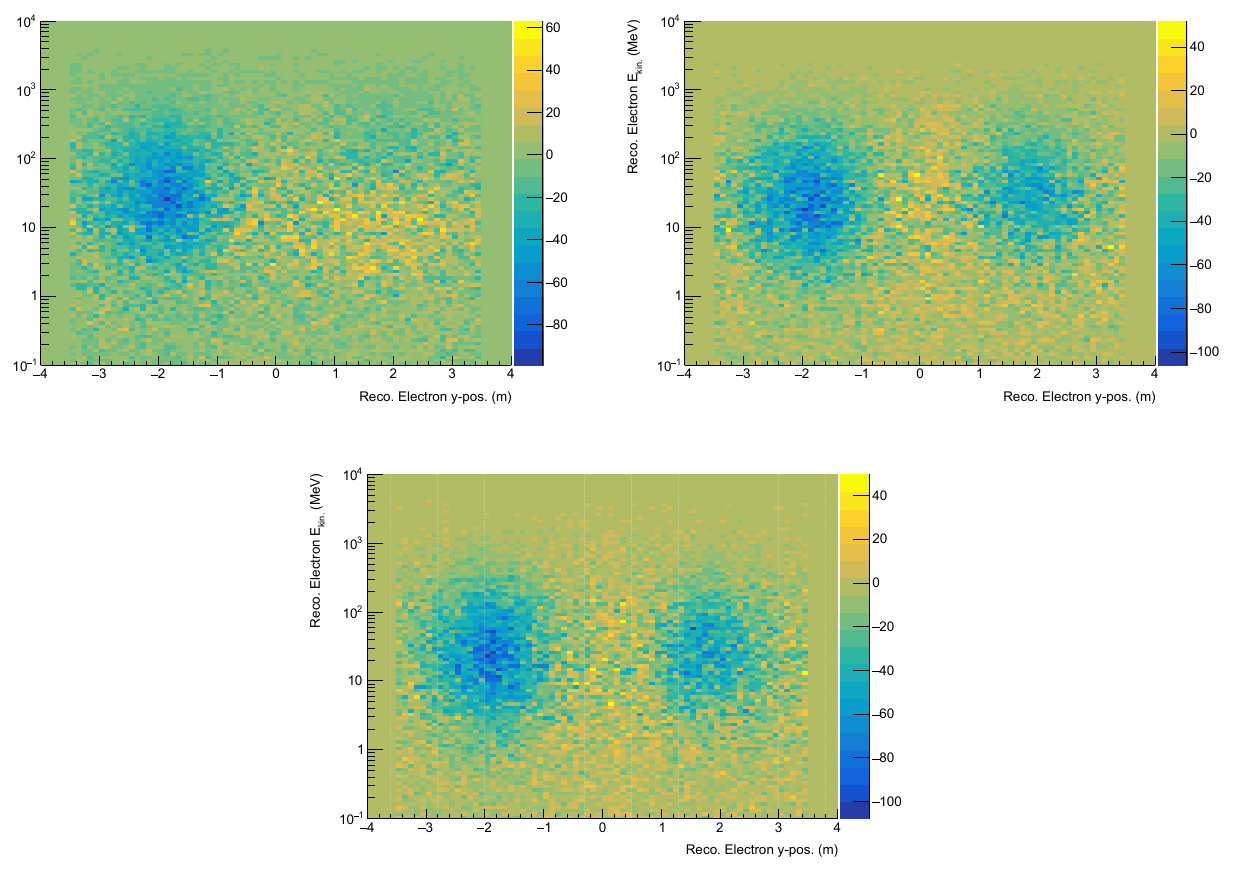
Figure 5. The distribution of the kinetic energy E kin . as a function of the y -position of the reconstructed electrons in the lower detector plane. The materials analyzed are Cesium ( top left ), Tin ( top right ) and Palladium ( bottom ). The hits from the empty container are